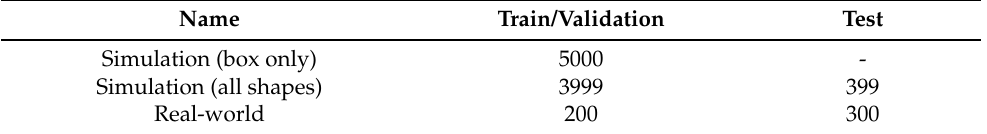
Table 2. The number of samples in datasets used in our experiments based on the